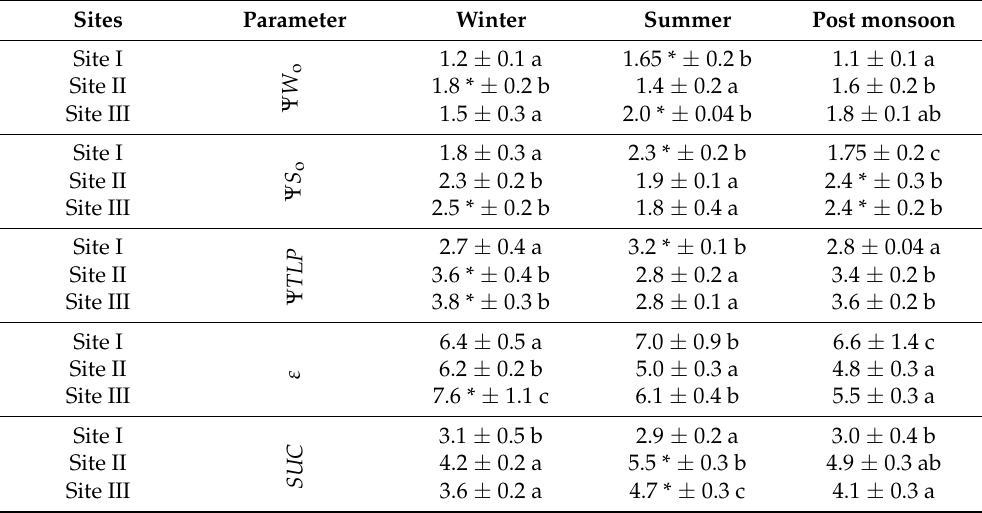
Table 3. Leaf Water relation parameters (-MPa) derived from PV-curves of Salvadora persica at Sandspit (Site I), Clifton (Site II) and Korangi (Site III). Ψ W o = Water potential at full turgor; Ψ S o = Osmotic potential at full turgor; Ψ TLP = Water potential at turgor loss point and ε = Bulk elastic modulus and Leaf Succulence (mg g − 1 DW). Different letters on error bars indicate significant differences among seasons on the same site ( n = 3) at p ≤ 0.05 (Bonferroni/Games-Howell tests wherever applicable). Asterisk (*) in mean values represent the most significant data. Sites Parameter Winter Summer Post monsoon Site I 1.2 ± 0.1 o W Ψ